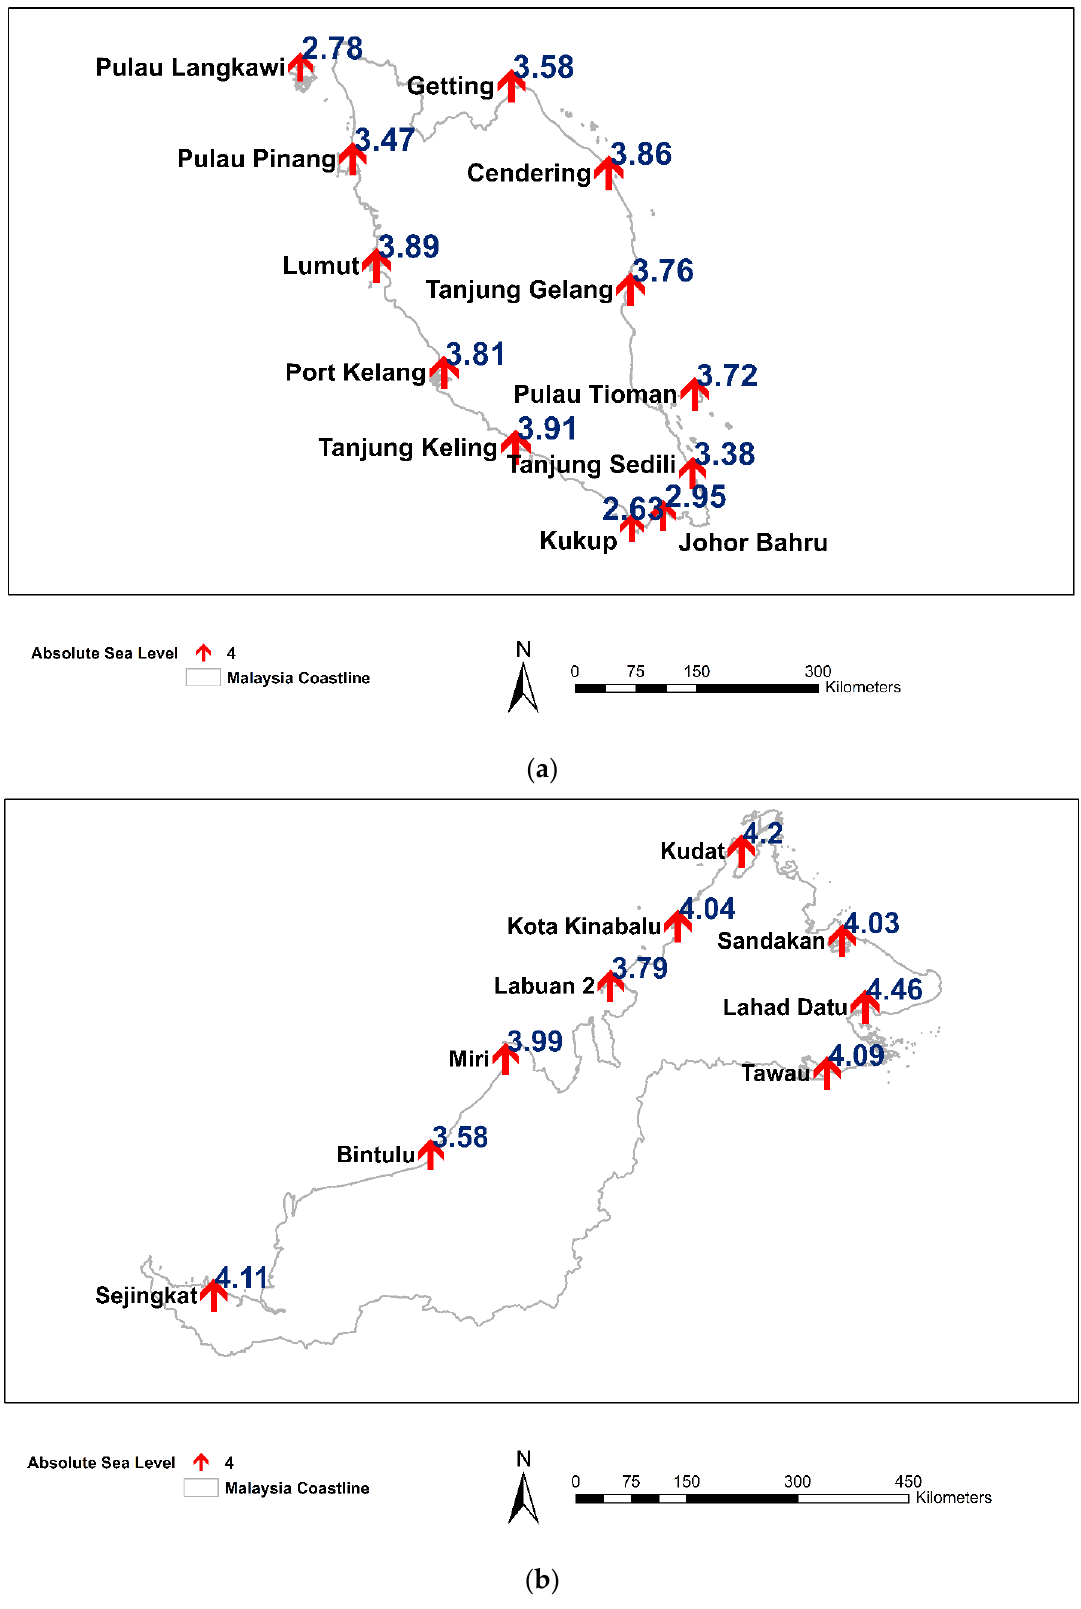
Figure 5. Absolute sea-level trends at ( a ) the Peninsular Malaysia coastline and ( b ) Sabah and Sarawak. Shorelines were extracted from the multi-sensor satellites at all 21 locations with tide gauges using the shoreline-detection method described above. The application of the au- tomated shoreline-detection method was first validated at a test site prior to its use at other tide gauge sites. Teluk Nipah was selected as the test site because a previous study [52] had been conducted at this location using the conventional approach. The change statistics for the shorelines extracted at the test sites using the robust shoreline-detection algorithm employed in this study are presented here. A total of 428 shorelines were cor- rectly extracted from the 825 images acquired over Teluk Nipah Beach. The inability to extract shorelines from some images was due to excessive cloud cover. The result of shore- line analysis at the test sites presented in Table 3 indicated both an erosion trend (negative values) and an accretion trend (positive values) occurred. NSM, EPR, LRR, and WLR sta- tistics showed that erosion occurred at 12 of the 14 transects. The average erosion trend was − 26.05 m, − 0.86 m/y, − 0.41 m/y, and − 0.51 m/y based on NSM, EPR, LRR, and WLR, respectively. Accretion occurred only at the two extreme ends of the transect: Transect IDs 1 and 14. The average accretion trend was 5.56 m, 0.19 m/y, 0.86 m/y, and 0.96 m/y based on NSM, EPR, LRR, and WLR respectively. The map and plot of the shoreline change rate for EPR, LRR, and WLR are shown in Figure 6. The mean shoreline change envelope was 59.14 m. Figure 7 shows the map and plot of the shoreline change distance for SCE and NSM. The mean of erosion/accretion values at all transects showed that erosion was more dominant across the coastline of Teluk Nipah Beach at a rate of − 0.711 m/y, − 0.23 m/y, and − 0.30 m/y based on EPR, LRR, and WLR, respectively. The result of a similar analysis con- ducted at the 21 tide gauge stations and the corresponding sea level change information is summarized in Table 4 below. The relationship between shoreline displacement and sea-level change based on the correlation of mean annual shoreline displacement and sea- level data is also provided in this table. Sea-level data were obtained from tide gauges and satellite altimetry to estimate the relative and absolute sea-level trend, respectively. How- ever, the tide-gauge data had missing values for some timestamps, and some stations had stopped providing records. In addition, some stations were flagged for errors in the